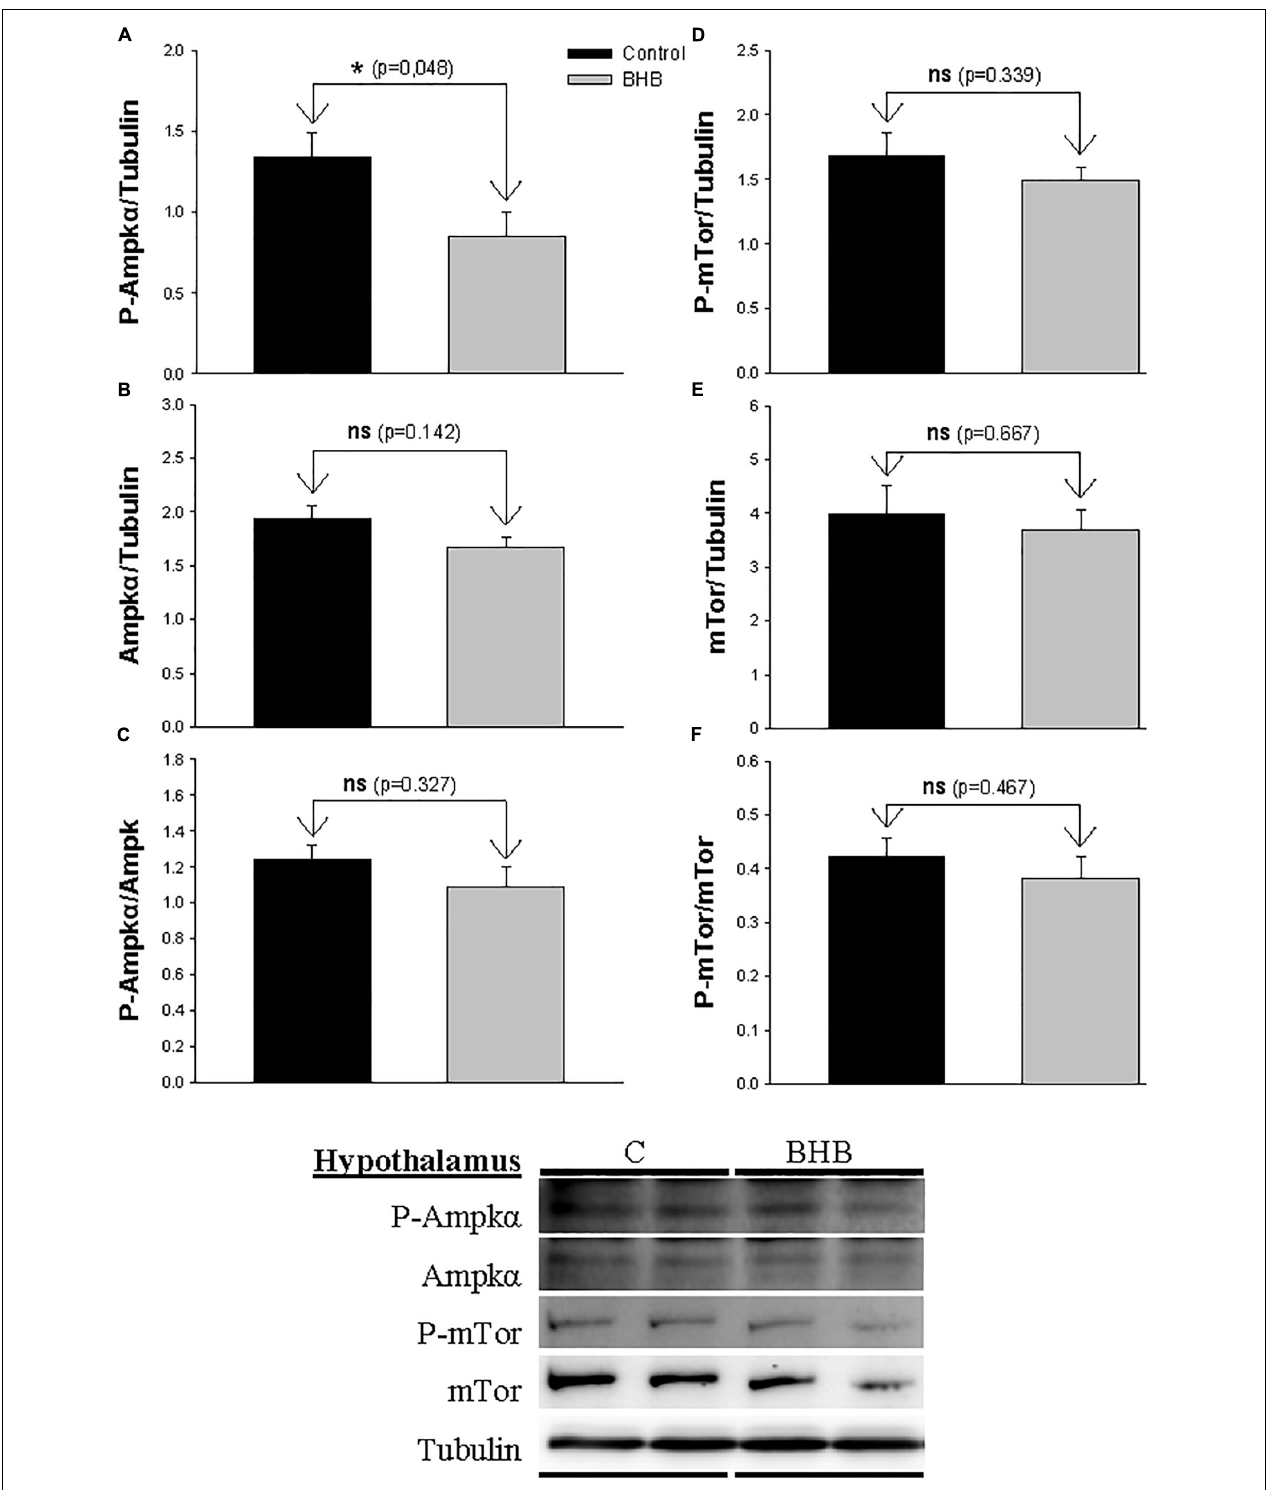
FIGURE 2 | Western blot analysis of Ampk α (A–C) and mTor (D–F) protein levels in hypothalamus of rainbow trout 6 h after intracerebroventricular administration of 1 µ L 100 g – 1 body mass of saline solution alone (Control) or containing 0.5 µ mol of β -hydroxybutyrate (BHB). Ten micrograms of total protein were loaded on the gel per lane. Western blots were performed on six individual samples per treatment, and representative blots are shown. Graphs represent the amount of phosphorylated protein (A,D) , the total amount of the target protein (B,E) and the ratio between the phosphorylated protein and the total amount of the target protein (C,F) . Each value is the mean + SEM of n = 6 fish per treatment. ns, not significant difference. ∗ indicates significant differences ( p < 0.05) compared to control group.